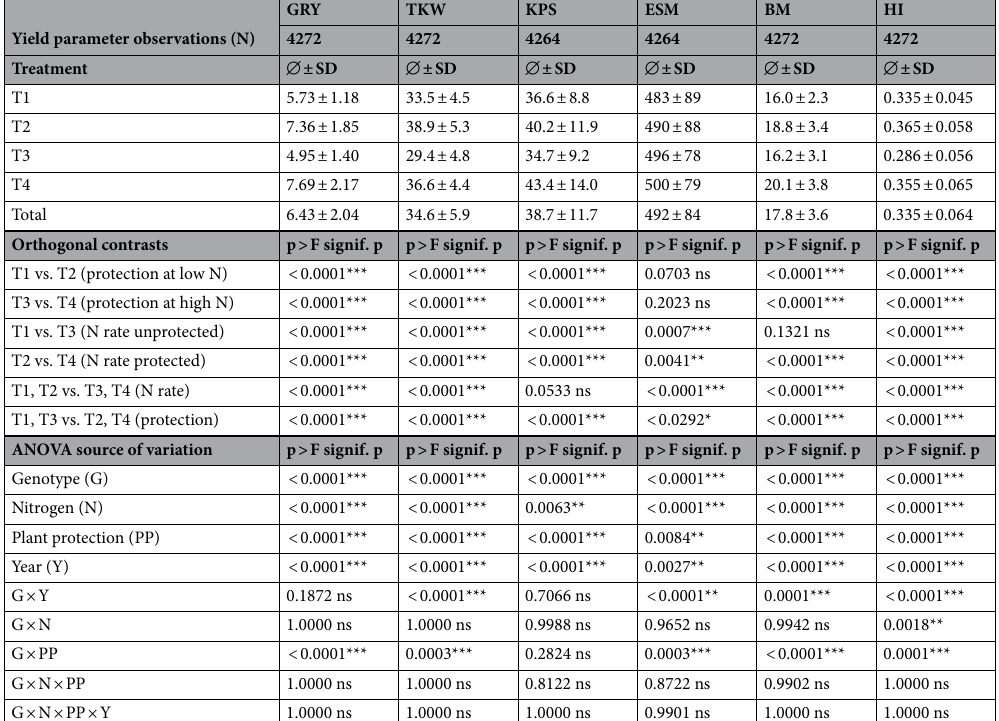
Table 2. Summary statistics, orthogonal contrasts between treatments based on LSmeans and ANOVA results of yield and yield components and ANOVA results with significance levels of 3-year field trials (2014/15, 2015/16, 2016/17) obtained on 178 wheat cultivars. GRY, grain yield in t/ha (average moisture 14%); TKW, 1000 kernel weight in g; KPS, kernels per spike; ESM, stand density/m 2 (productive spike numbers/m 2 ); BM, aboveground biomass (ATM) in t/ha; HI, harvest index; T1–T4, treatments T1